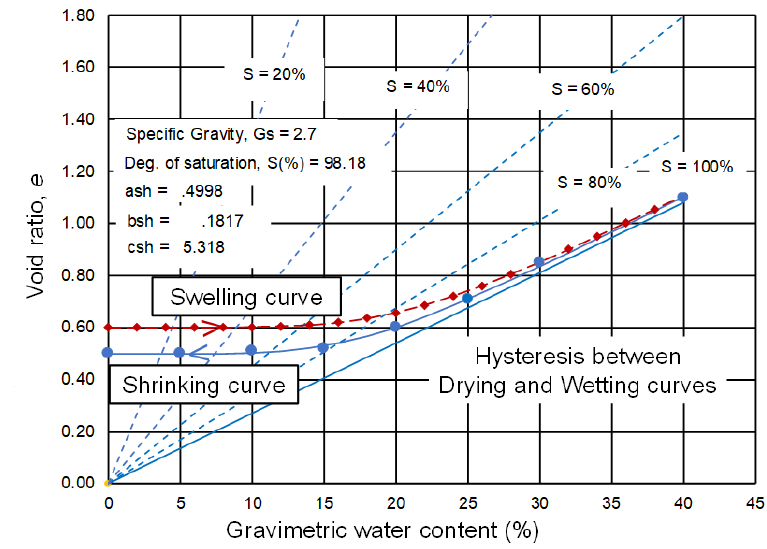
Figure 27. Illustration of hysteresis between drying and wetting shrinkage curves.